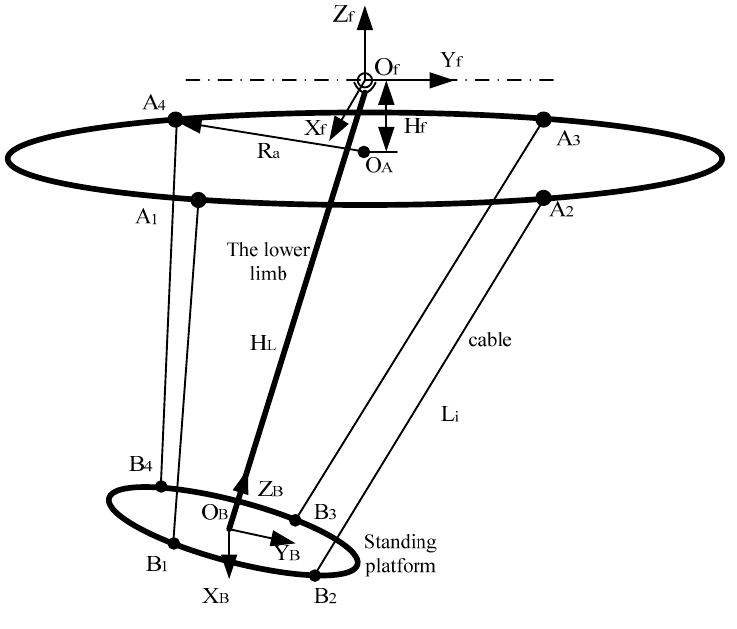
Figure 6. Coordinates and kinematic analysis of the lower limb traction device.